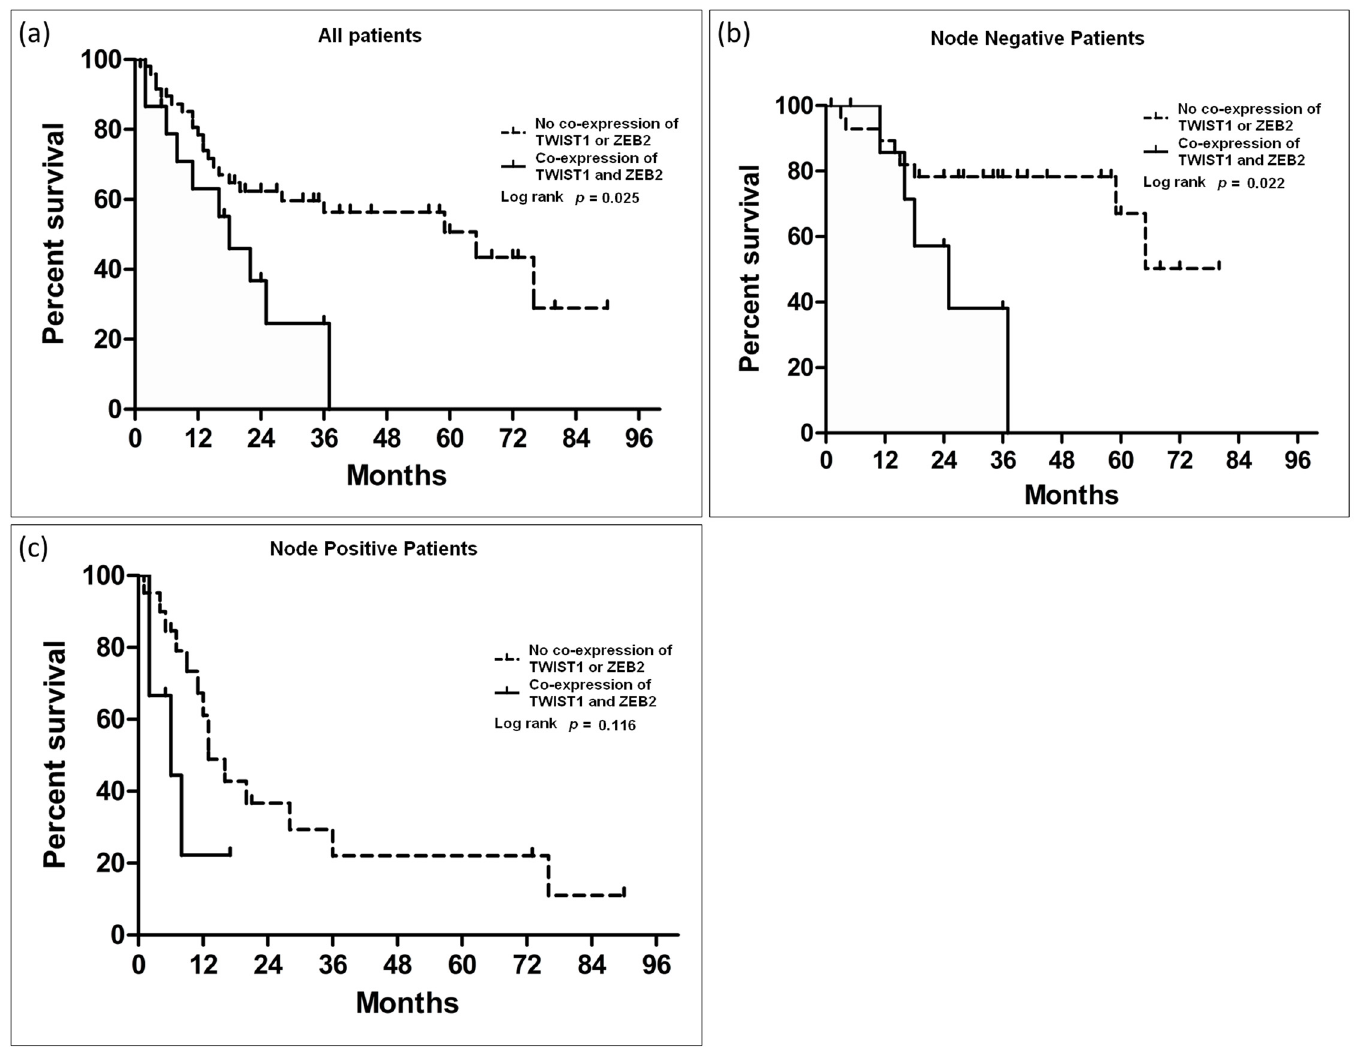
Fig 2. Association of co-expression of TWIST1 and ZEB2 with survival. (a) OSCC patients with co-expression of TWIST1 and ZEB2 have poorer overall survival compared to patients with no co-expression of these two proteins. Co-expression of TWIST1 and ZEB2 is significantly associated with overall survival in node negative OSCC patients (b) but not in node positive OSCC patients (c).